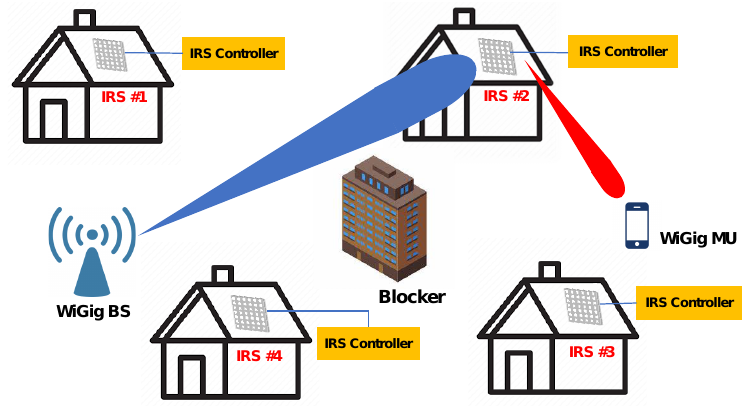
Figure 1. IRS-enabled WiGig